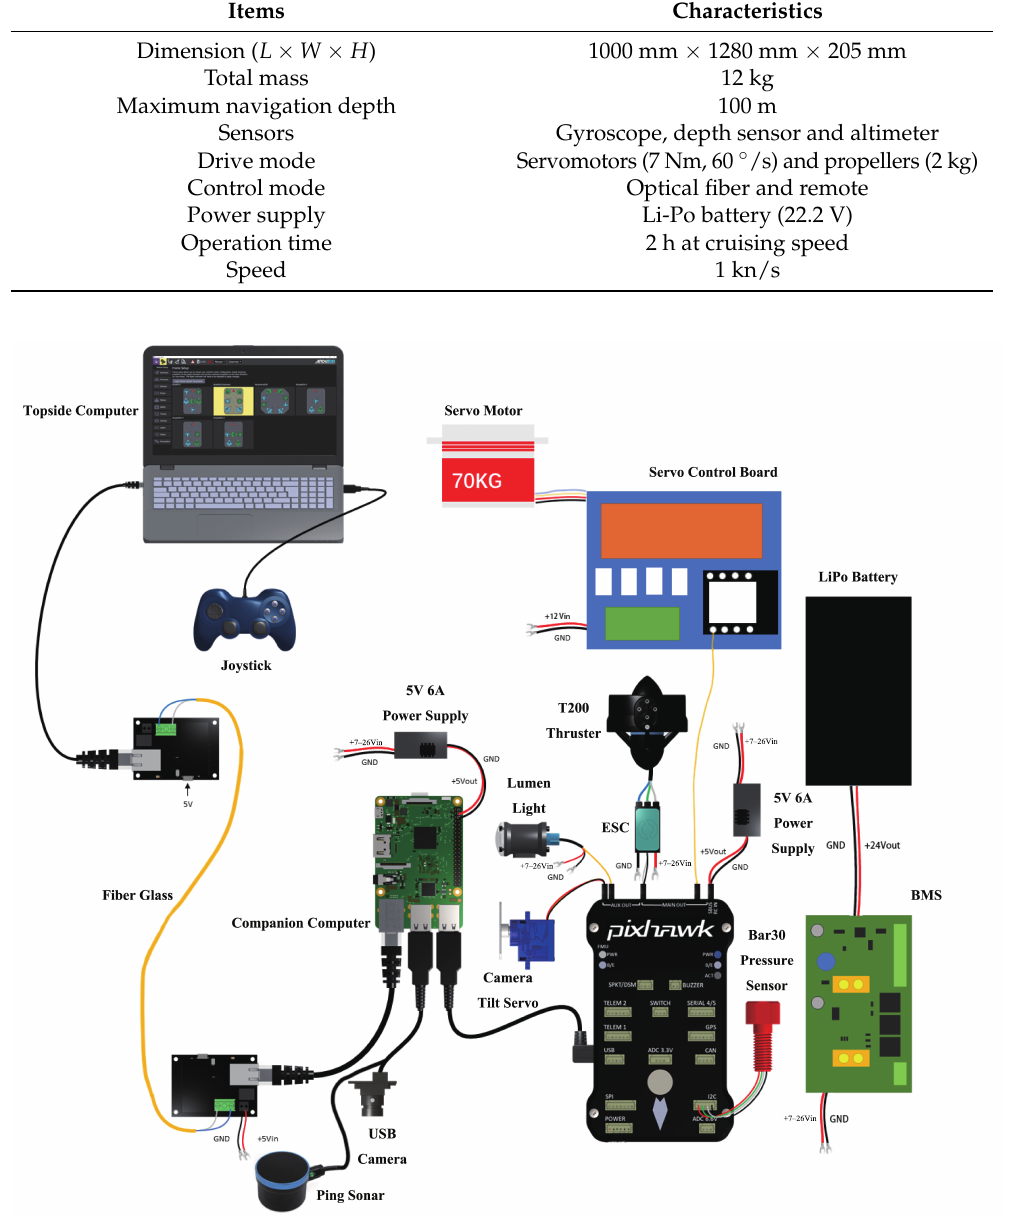
Figure 5. Hardware connection